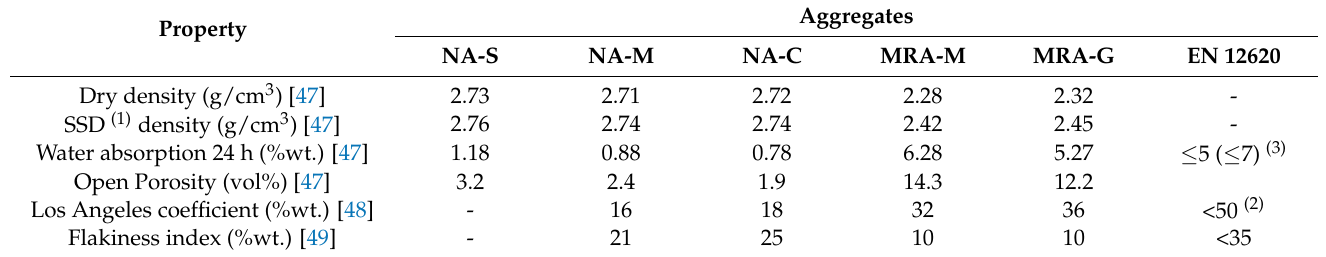
Figure 1. Aggregate particle size distribution. Note: NA-S: natural sand (0/6 mm); NA-M: natural medium gravel (6/12 mm); NA-C: natural coarse gravel (12/22 mm). Table 3. Physical properties of aggregates.